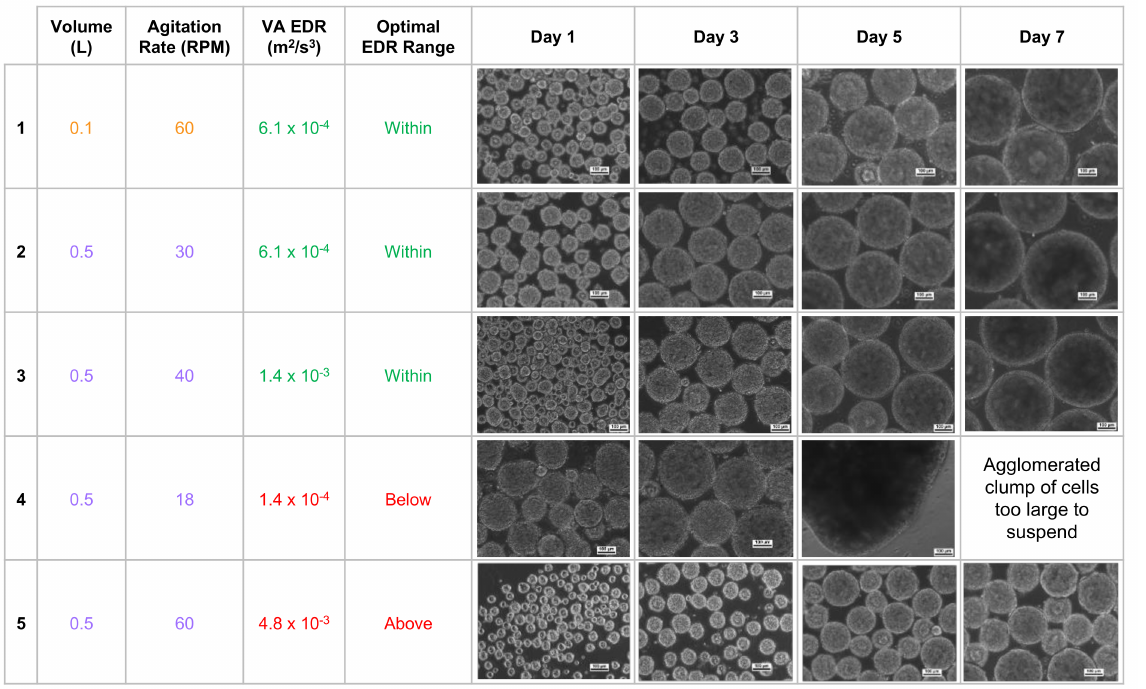
Figure 4. Observed morphologies of iPSC aggregates for different combinations of VW working volume and agitation rate. Uniformly spherical aggregates correspond to average EDRs that fall within the optimal range. There is also an inverse correlation between average EDR and aggregate size. Photomicrographs were taken at 10 × magnification. Scale bars: 100 µ m. Adapted from Dang et al. (2021)